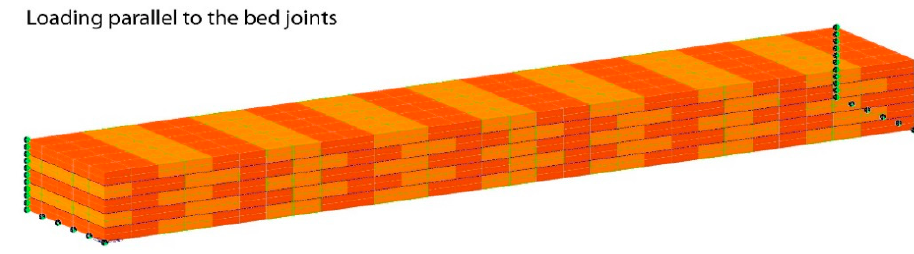
Figure 4. Finite Element Model: constraints of a beam made by five layers of solid clay bricks 60 mm thick for loading parallel to the bed joints.